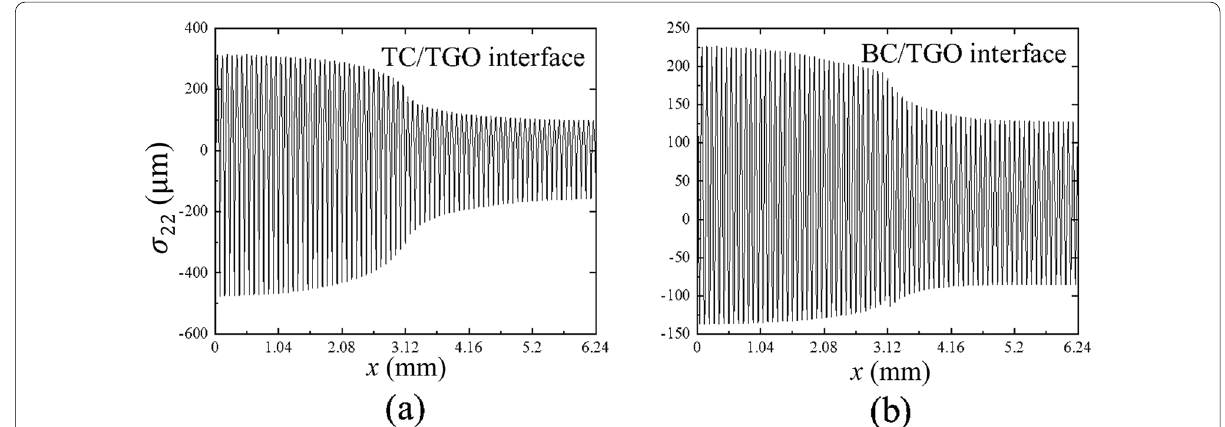
Figure 8 Distribution of σ 22 at ( a ) TC/TGO, and ( b ) BC/TGO interface of multi-period global model of APS TBCs